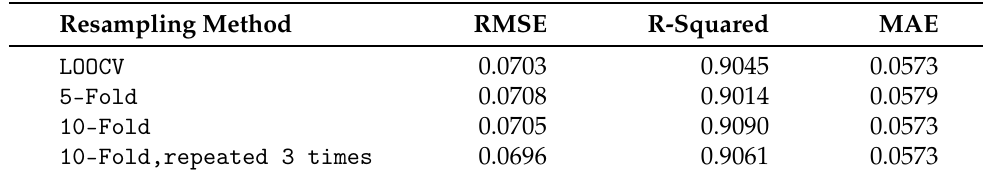
Table 4. Different cross-validation methods for measuring the performance of the predictive ( 3 ) with the test data